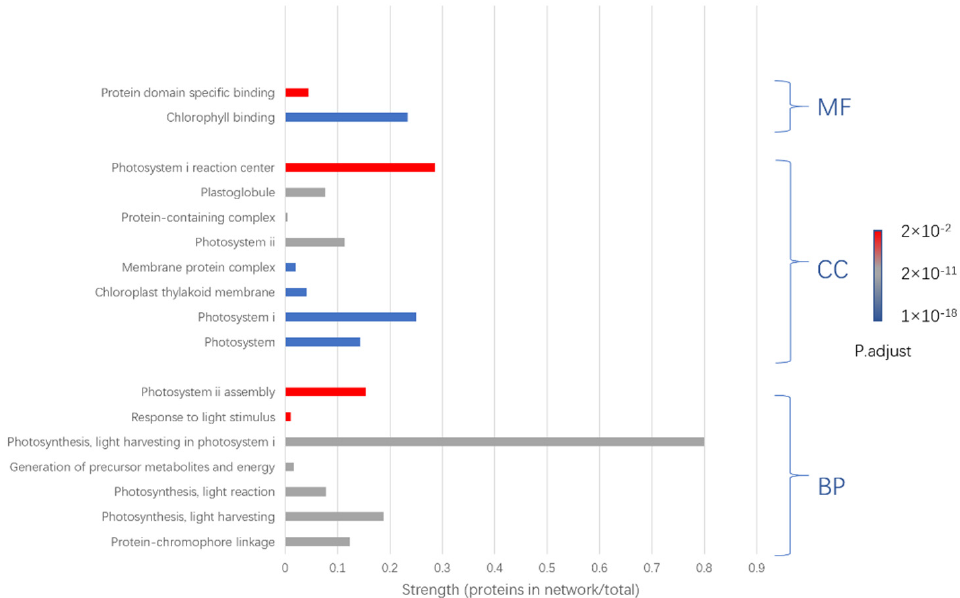
Gene Ontology classification of the differential proteins of purple-red cultivars. MF: molecular function, CC: cellular component, BP: biological process. p . adjust < 0.05 refers to significant difference among the accessions.